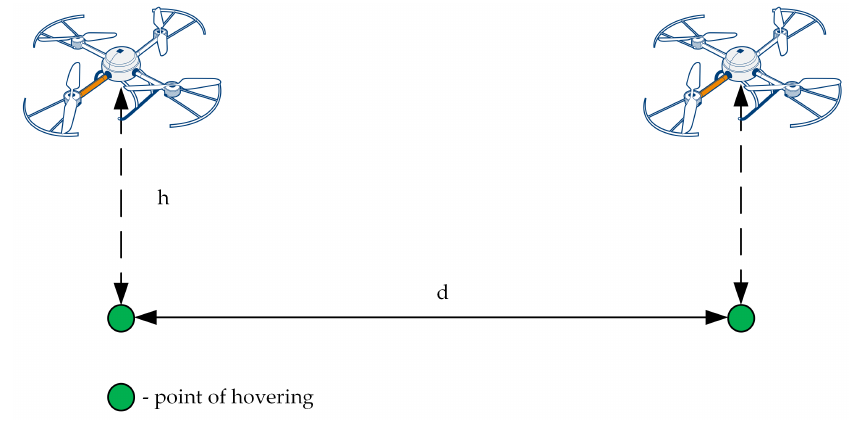
Figure 3. Scheme of flight between two points of